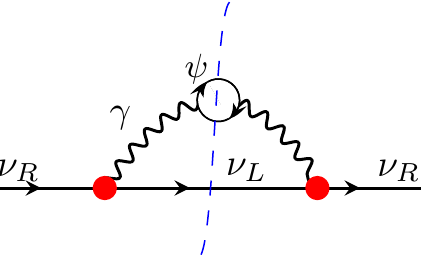
Figure 2 . The self-energy diagram of ν R in the presence of neutrino magnetic moments (red blobs). The photon propagator is resummed to include the charged-fermion loop. In thermal QFT, the evaluation of this diagram can be used to obtain the total ν R production rate which automatically includes the contributions of plasmon decay and scattering processes. For instance, the dashed cut leads to a tree-level diagram corresponding to the on-shell scattering shown in figure